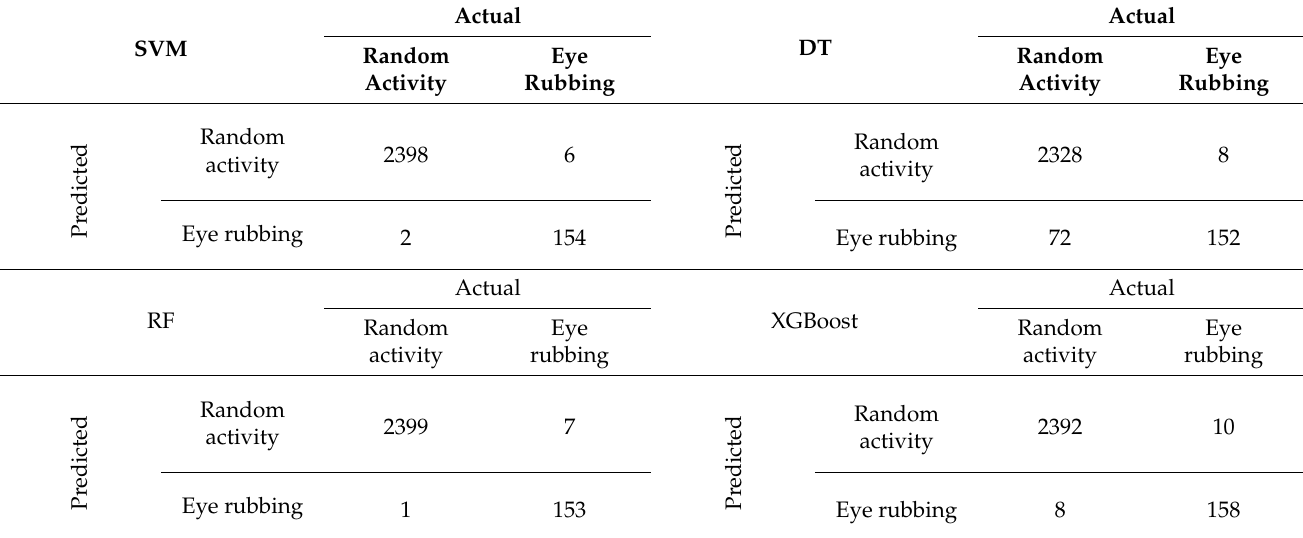
Table 2. Combined confusion matrices of experimental